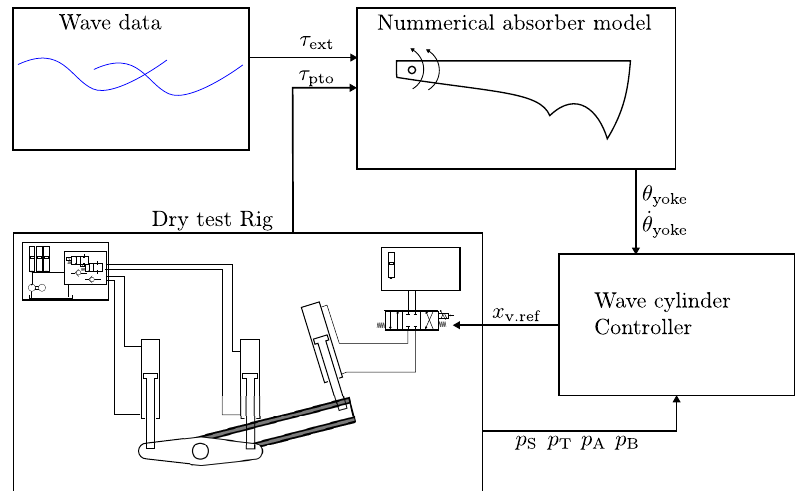
Figure 3. Control and reference concept illustration for the dry test